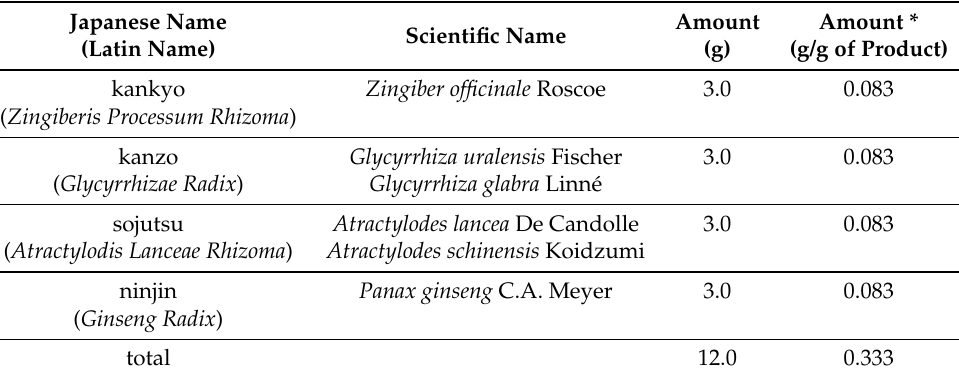
Table 6. The ingredients in the ninjinto (TJ-32)